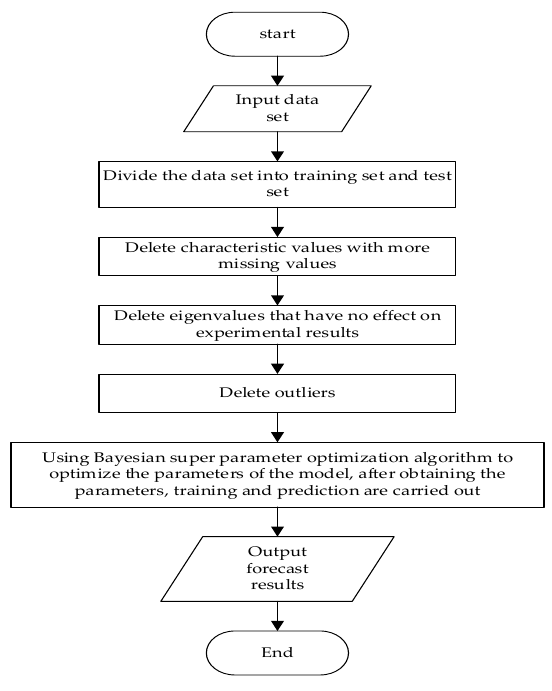
Figure 5. Experiment flow chart.